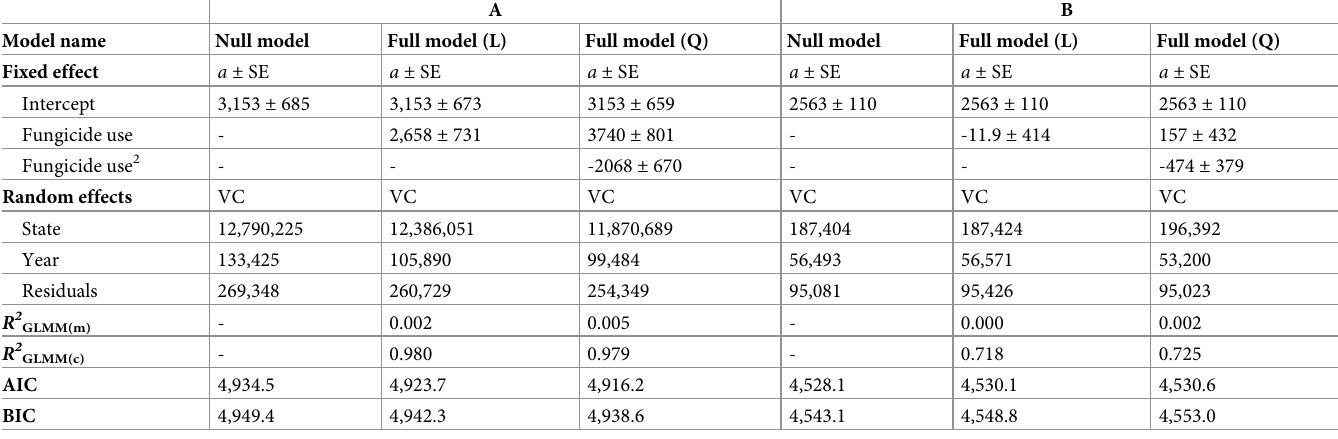
Table 2. Mixed-effects modelling of the effect of foliar fungicide use on soybean production/yield from soybean growing states in the United States during 2005– 2015 period at national scale. A = annual total fungicide use in MT and annual total production in 1,000 MT. B = annual total fungicide use in g/ha and annual yield in kg/ha. States considered for this study included IL, IN, IA, KS, MI, MN, NE, ND, OH, PA, SD, WI,AL, AR, DE, FL, GA, KY, LA, MD, MS, MO, NC, OK, SC, TN, TX, and